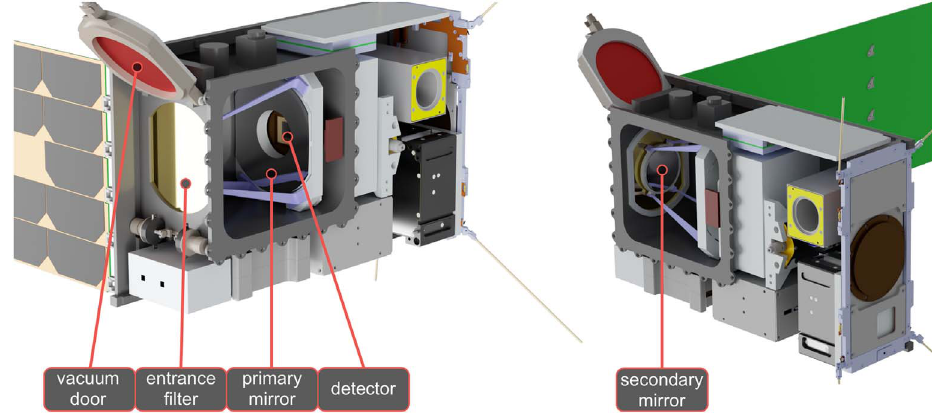
Fig. 8. SunCET ’ s compact Ritchey-Chrétien telescope, which fi ts inside a 6 U CubeSat with all typical bus components.